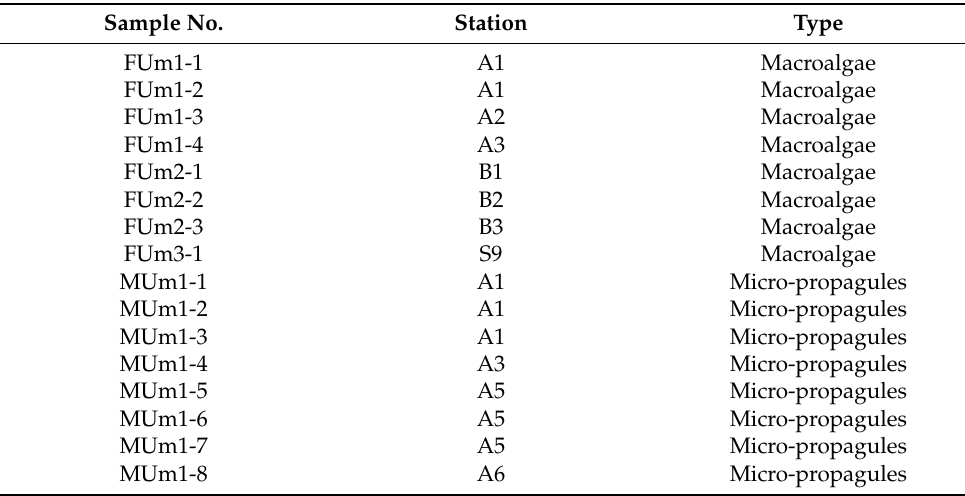
Table 3. Description of the different macroalgae and micro-propagules. Sample